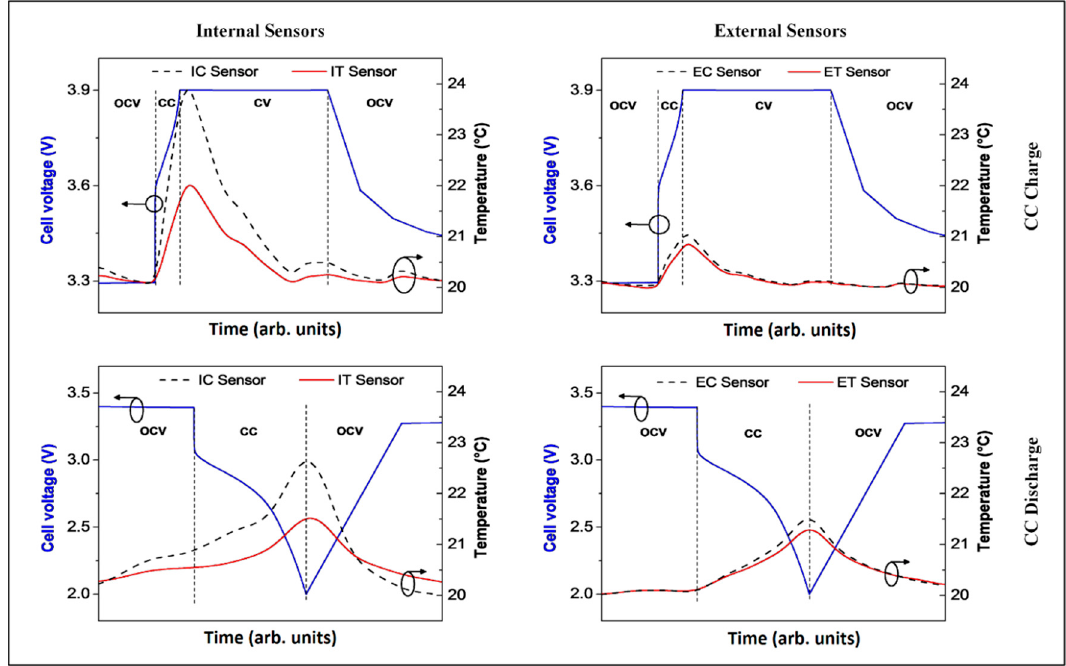
Figure 3. Temperature changes observed with all four sensors before, during and after a CC discharge or CCCV charge half cycle (C-rate was 5C) followed by an OCV step.